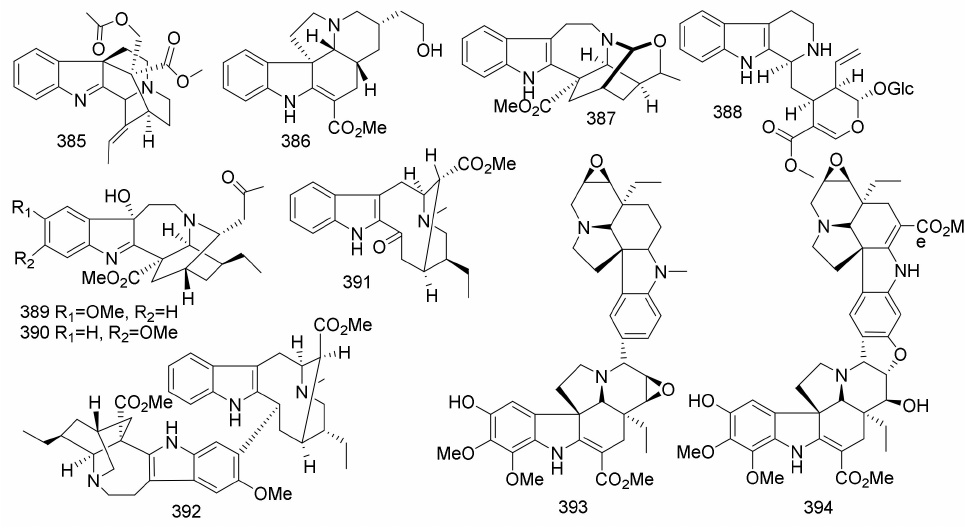
Figure 30. Compounds 385 – 394